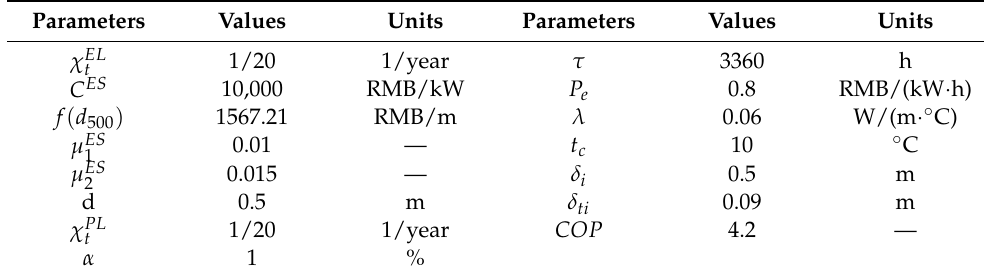
Table 1. Table of simulation